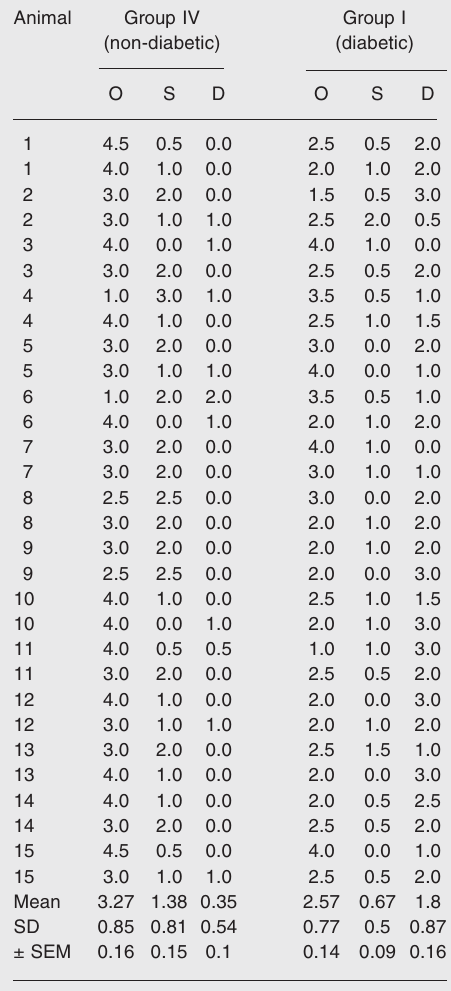
Table 2. Remyelination scores 31 days after ethi- dium bromide injection in groups I (diabetic rats) and IV (non-diabetic